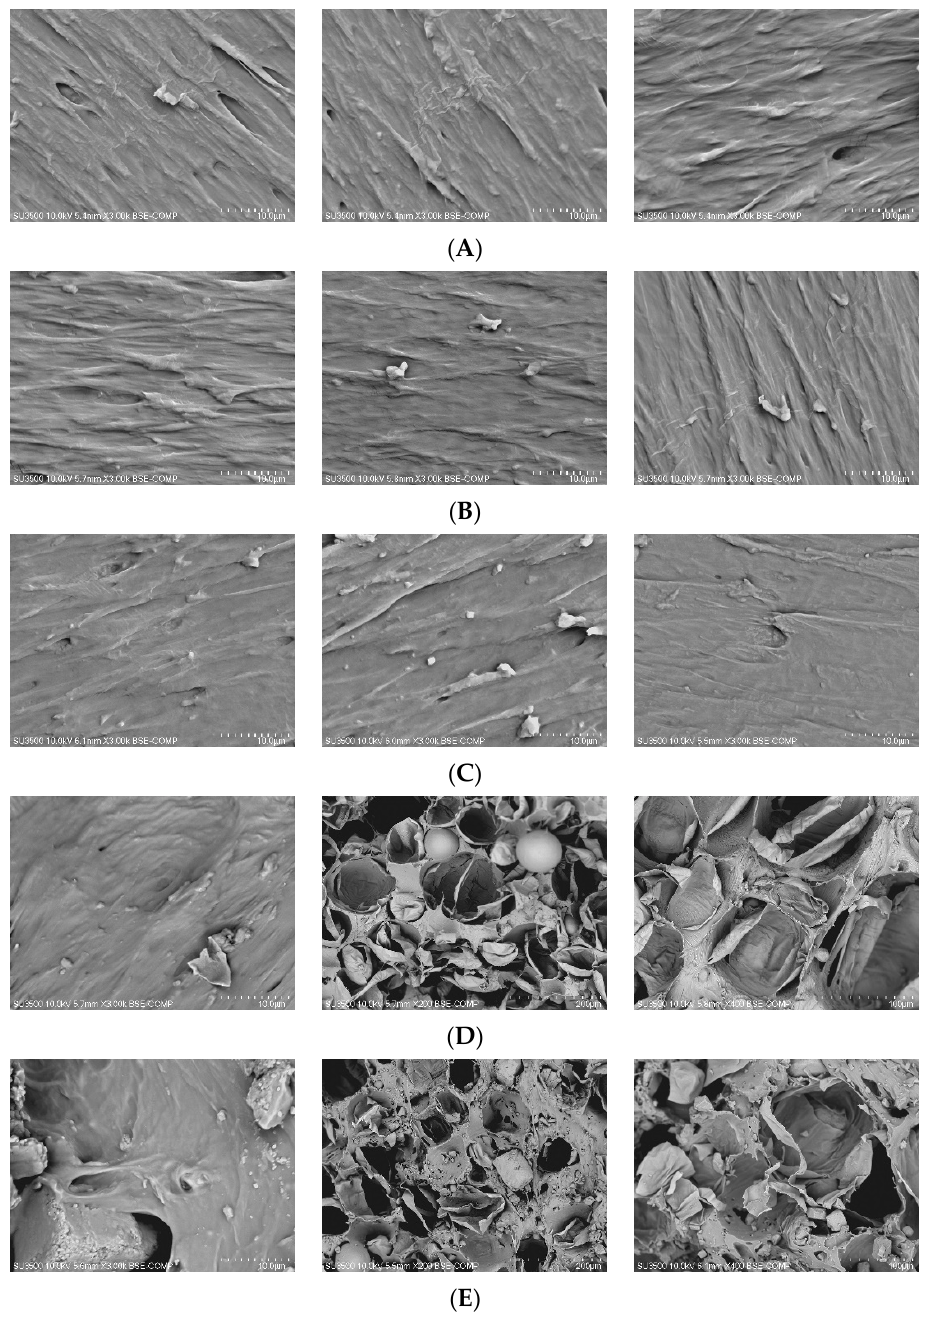
Figure 3. SEM images of the test polymer composites.